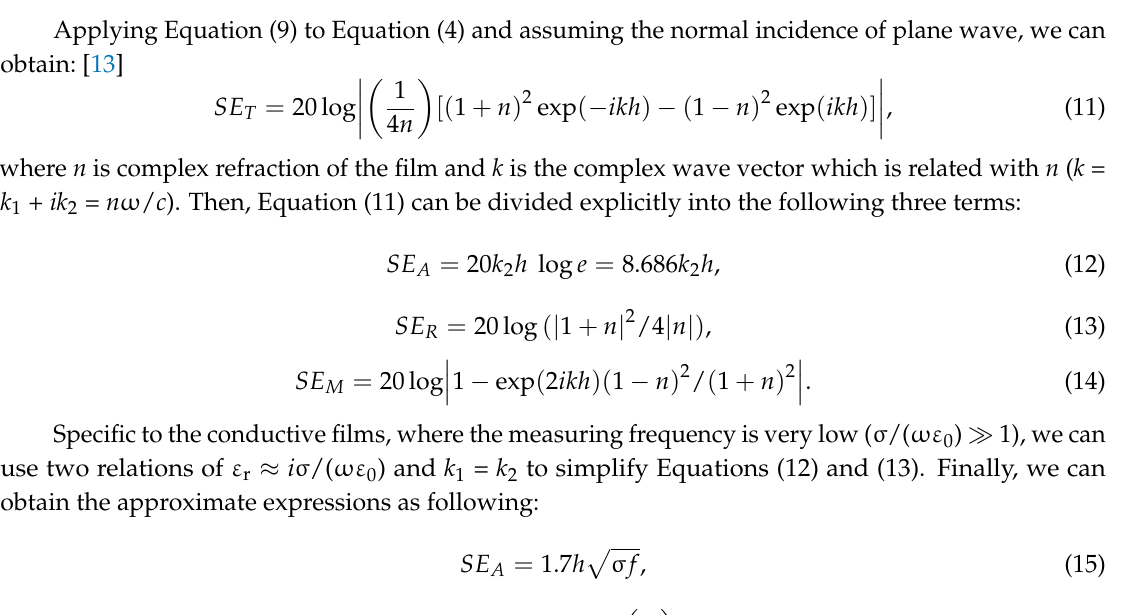
Figure 1. Theoretical model of obliquely-incident TE-wave of a conductive thin film in vacuum. In this picture, E and H represent electric field and magnetic field, respectively, θ 0 is the incident angle, θ 1 is the refracting angle in the film, and h is the thickness of the film.